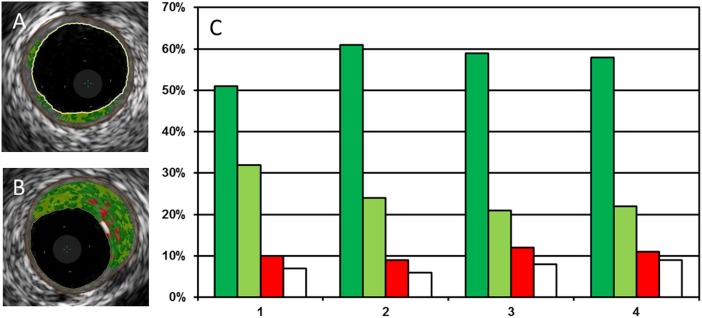
Distribution of plaque tissue composition in areas exposed to different levels of endothelial shear stress (ESS).Panel (A) shows an example of an early, panel (B) an example of a more advanced atherosclerotic lesion as assessed by intravascular ultrasound radiofrequency data analysis. Fibrous tissue is represented by dark green, fibrofatty tissue by light green, necrotic tissue by red and calcified tissue by white colour. We observed a significantly higher amount of fibrofatty (*) tissue in areas exposed to the lowest level of ESS (quartile 1) in comparison to low-intermediate ESS (quartile 2), intermediate-high ESS (quartile 3) or high ESS (quartile 4) (p≤0.023) (C). There was no difference in the amount of other tissue types depending on the level of ESS (p≥0.061).